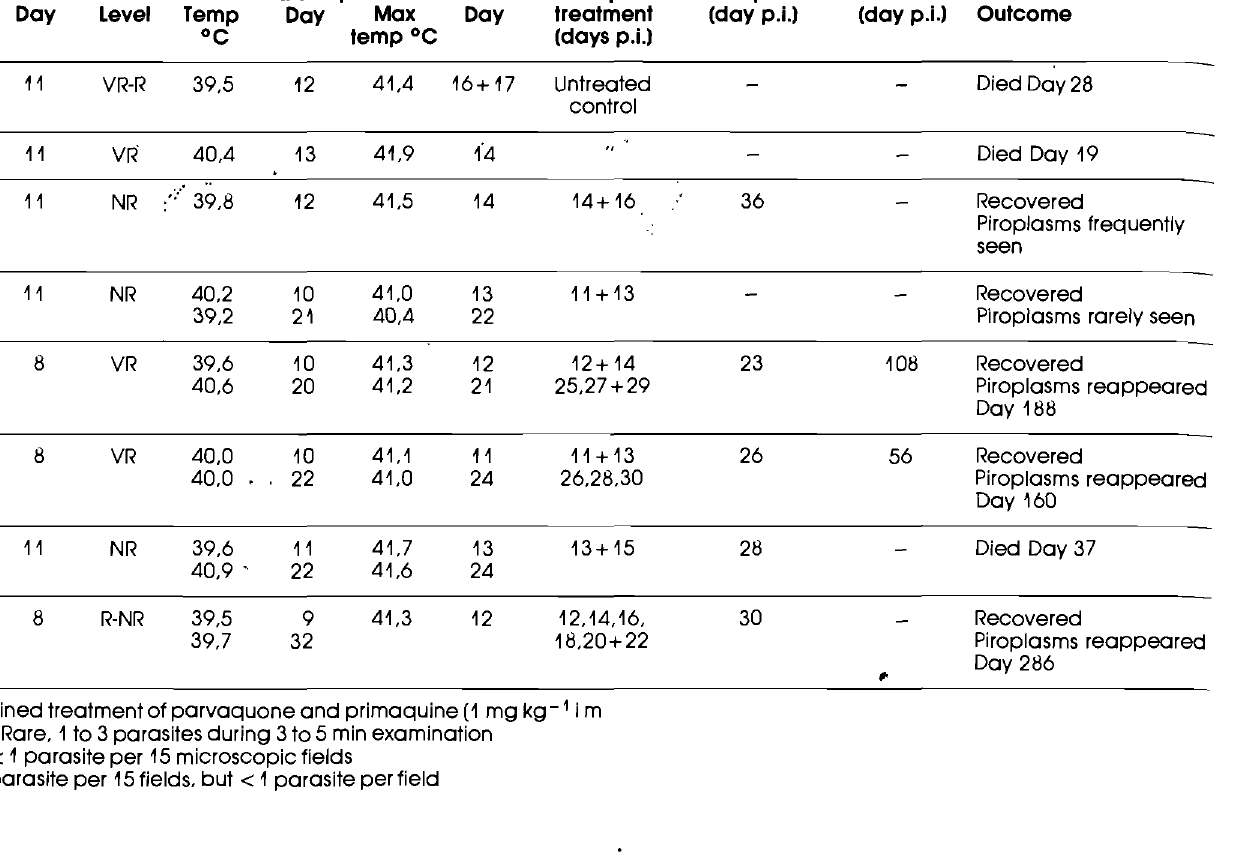
Table 4. Comparative infection rates of Theileria parva lawrencei in adult Rhipicephalus zambeziensis and Rhipicephalus appen· dicu/atus fed concurrently as nymphae on the same two T. p. lawrencei